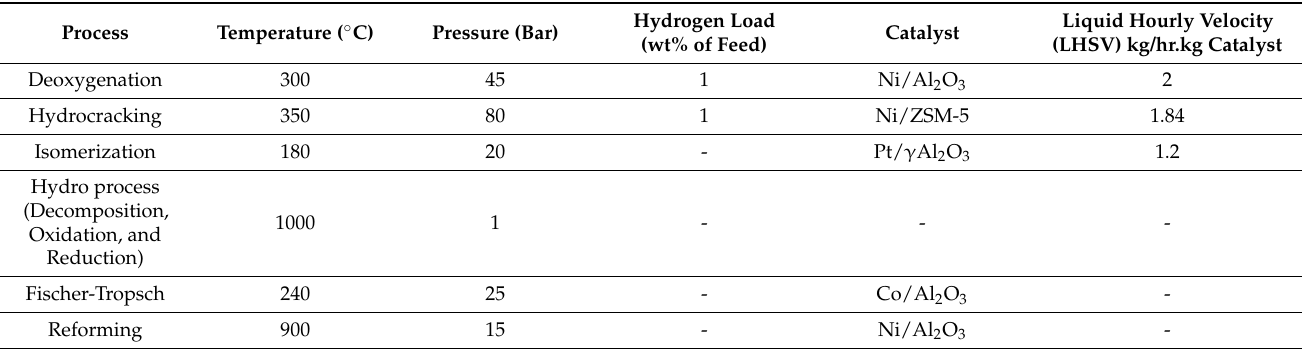
Table 8. Physical parameters for the